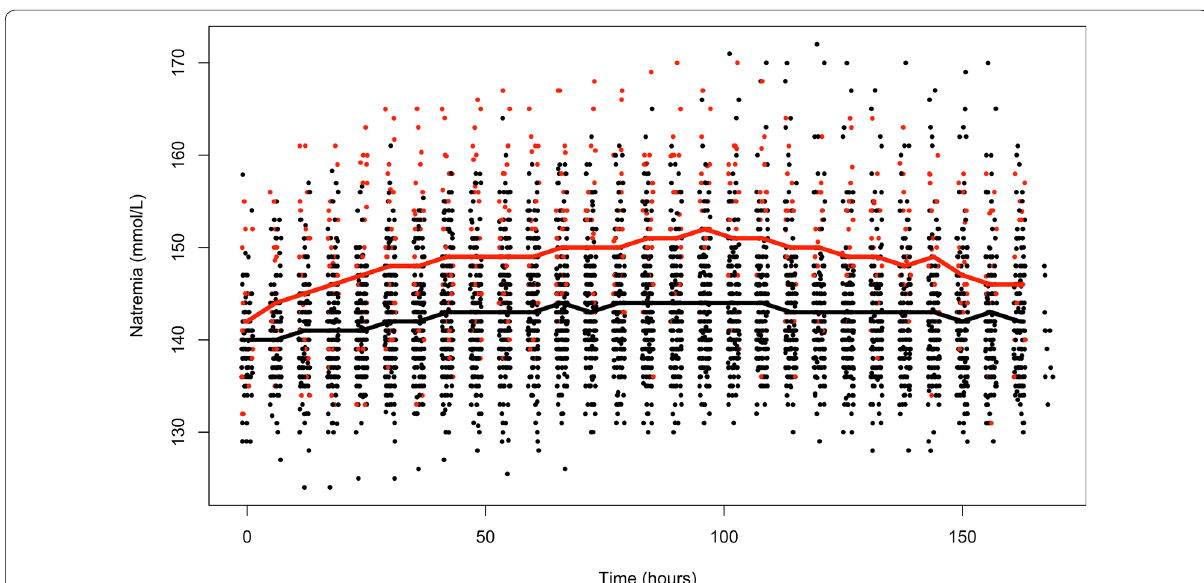
Fig. 1 Natremia during ICU stay according to desmopressin administration status. Red dots natremia at a given time in patients who received = desmopressin, Red curve average natremia over time in patients who received desmopressin. Black dots natremia at a given time in patients = = who did not receive desmopressin, Black curve average natremia of patients who did not receive desmopressin. p < 0.001 for natremia over time = between patients who received desmopressin and those who did not receive desmopressin (two-way